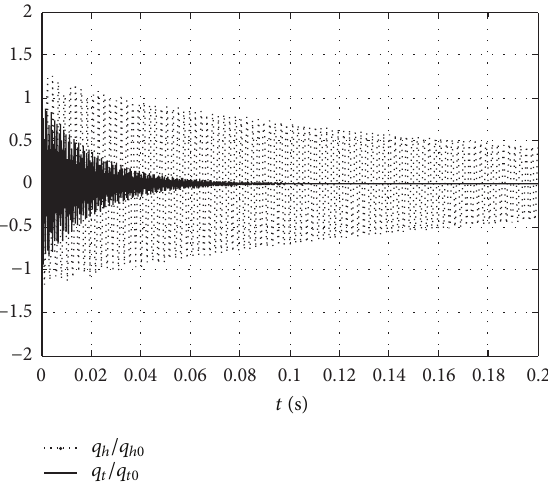
Figure 10: Velocity versus time plot of the generalized coordinate of the beam with piezoelectric attachment, 𝑅 = 0.001 , 𝜇 𝑥ℎ1 = 30 , = 0.2 , 𝑈 = 95 m/s, and 𝑉 𝜇 V ℎ1